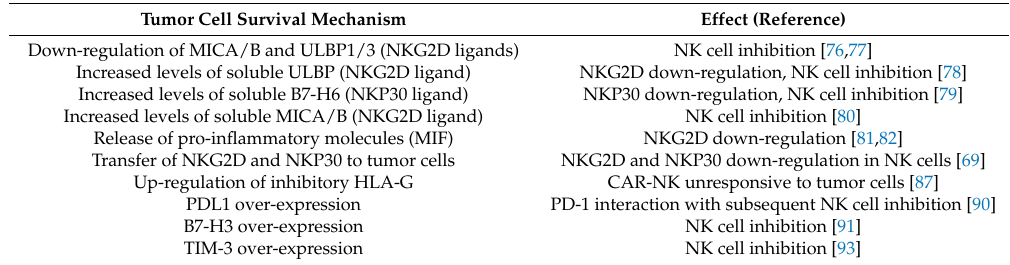
Table 3. Tumor cell survival mechanisms developed by tumor cells against NK cells. Tumor Cell Survival